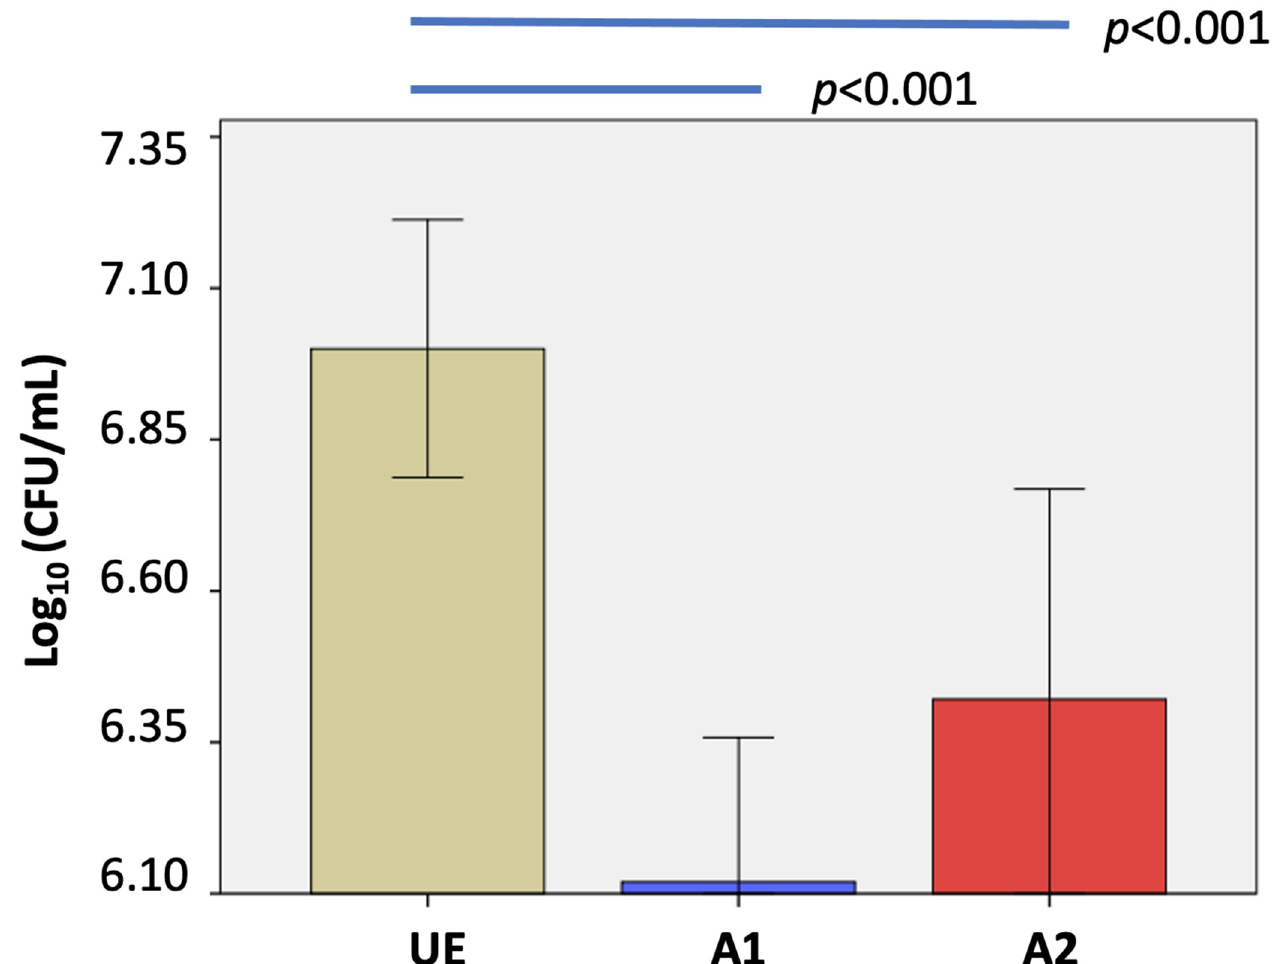
Figure 4. The colony forming units (log 10 CFUs/mL) at 24 h of Candida albicans exposed and unexposed to EFs and cultivated on resin discs. UE were the unexposed controls. A1: one complete session of the antibacterial protocol with CMFs. A2: two complete sessions of the antibacterial protocol with CMFs. Statistical significance with p < 0.05. Error bars = standard deviation.